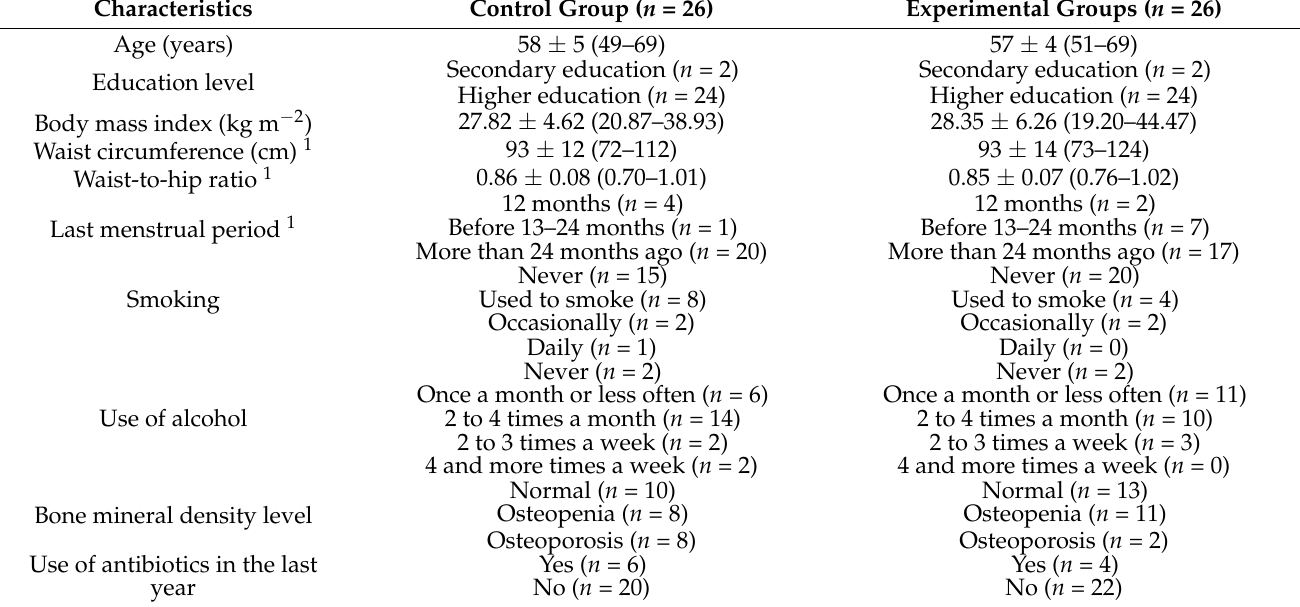
Table 2. Characteristics of the